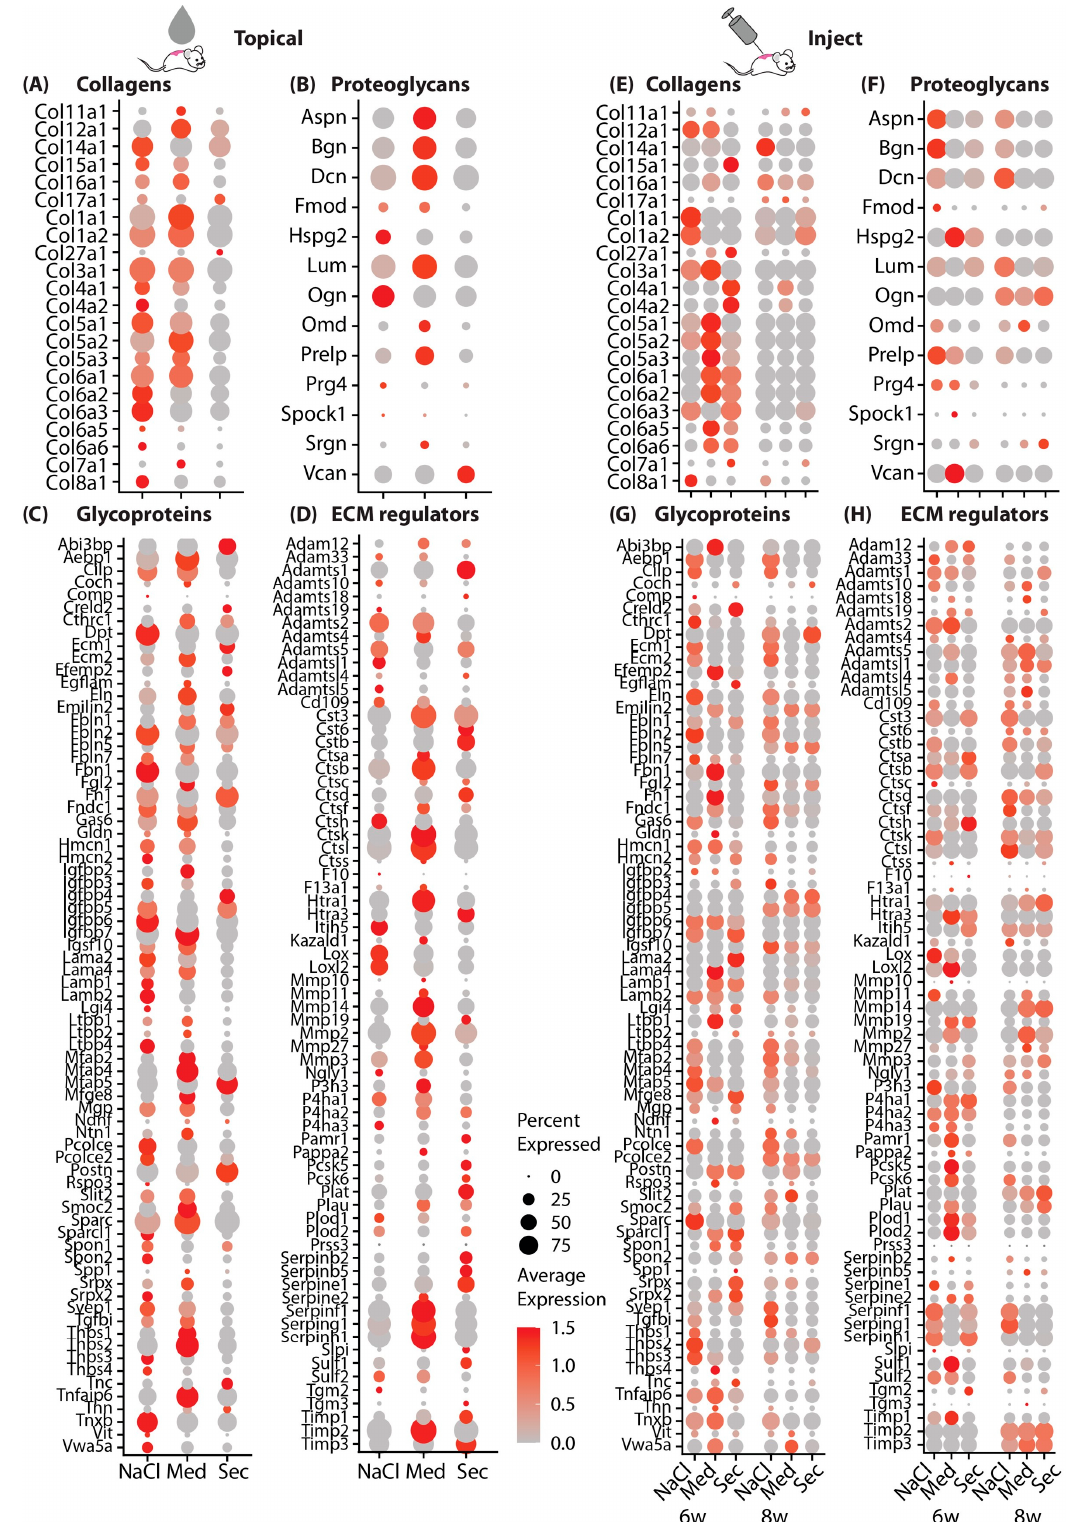
Figure 3. PBMCsec significantly alters the matrisome. Dot plots of gene lists of gene set enrichment of matrisome terms ( A , E ) “collagens”, ( B , F ) “proteoglycans”, ( C , G ) “Glycoproteins”, and ( D , H ) “ECM regulators” inputted to FBs of the “topical” ( A – D ) and “inject” ( E – H ) datasets, split by condition. Circle size correlates with the percent of cells expressing the respective gene, and color (red) correlates with normalized fold change in expression.